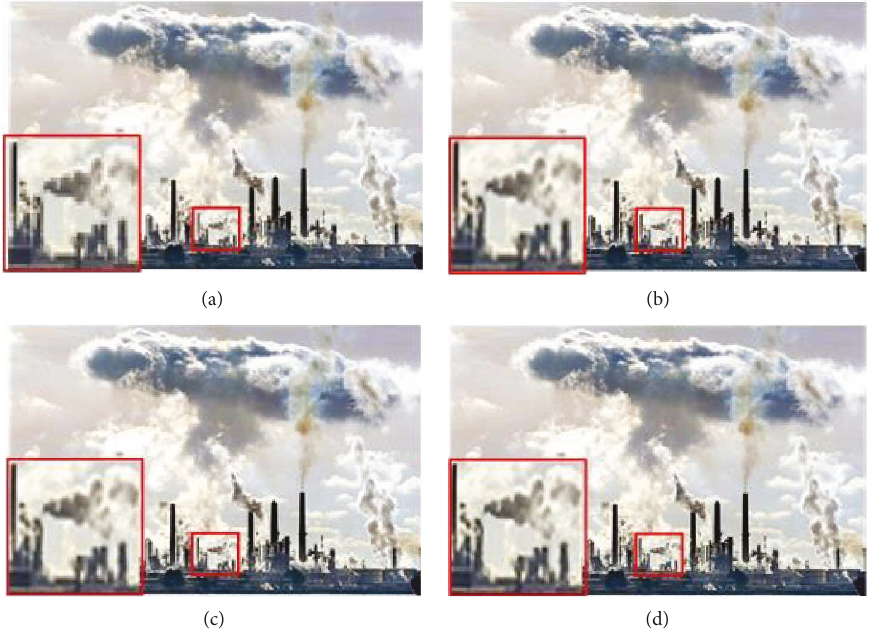
Figure 4: LR chimney image and reconstructed HR image by di ff erent methods: (a) LR image, (b) reconstructed image by the bicubic method, (c) reconstructed image by Zeyde et al. ’ s method, and (d) reconstructed image by the proposed